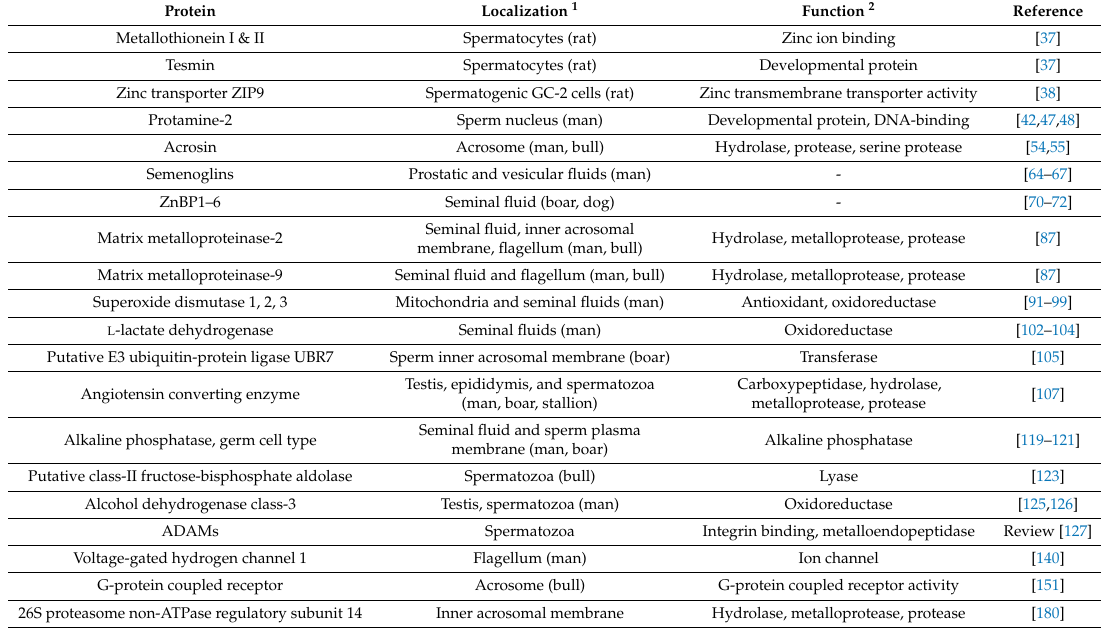
Table 1. General summary of testicular/sperm Zn-containing and interacting proteins reviewed, in order of